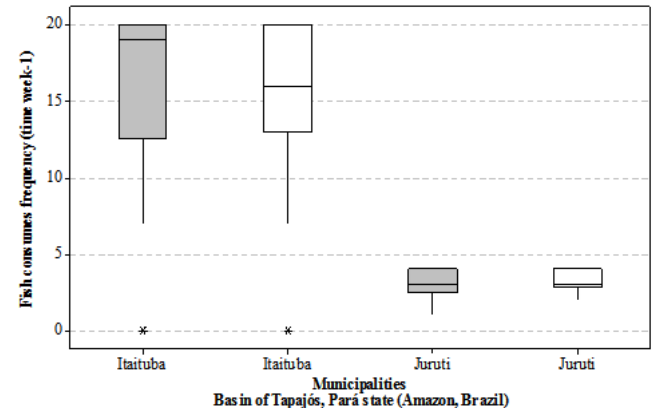
Figure 7: Fish consumes frequency of riverine inhabitants belonging to Barreiras community (area impacted by gold mining underground) and Tabatinga community (area without mining impact), masculine genus and feminine genus, belonging to the Tapajós basin, Pará state (Amazon, Brazil). The interaction between fish consumption frequency (times/week), Hg, CH 3 Hg + and Se concentrations in hair samples by riverine inhabitants belonging to Barreiras